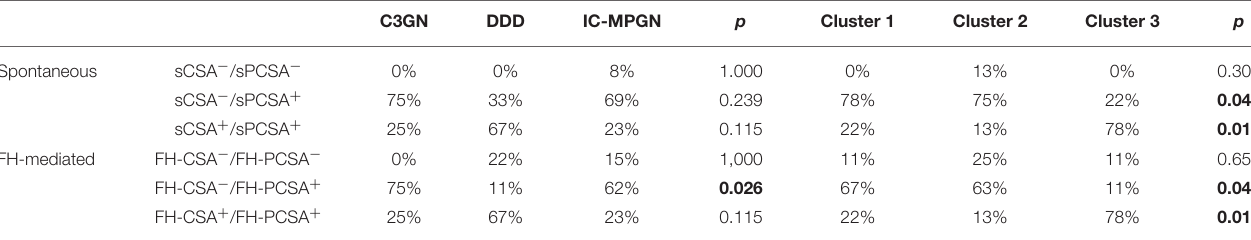
TABLE 3B | Prevalence of patients with C3NeF IgGs with properdin (P) independent (CSA + /PCSA + ) or dependent (CSA–/PCSA + ) C3 convertase stabilizing activity against spontaneous (s) or FH-mediated (FH) decay among histology groups or clusters.